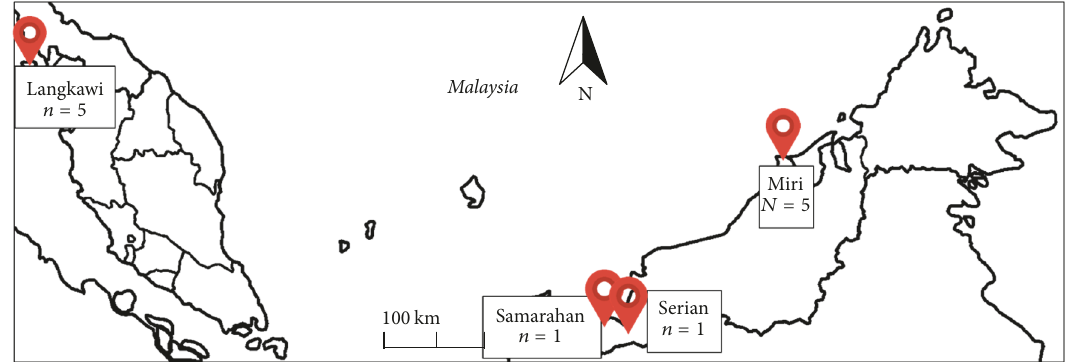
Figure 1: Locations of T. schlegelii populations involved in this study.